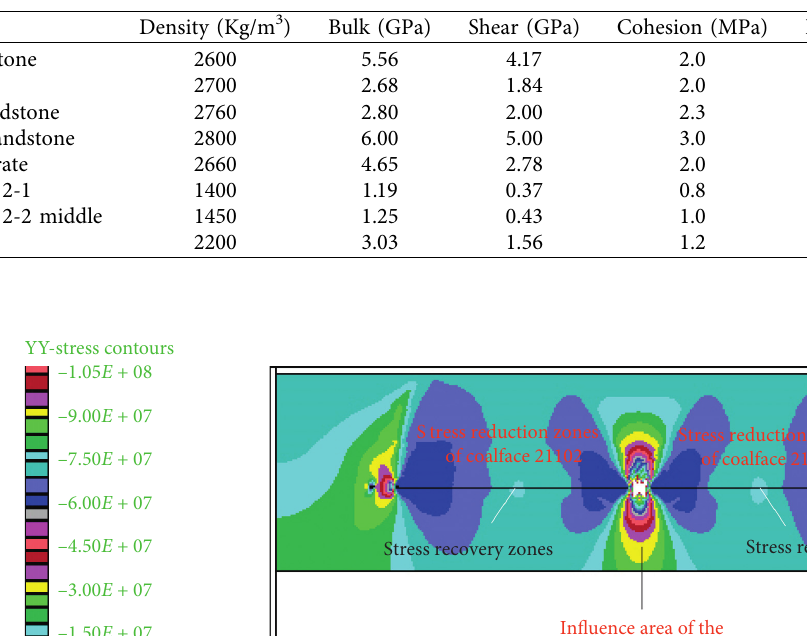
Figure 4: FLAC numerical model after mining the protective seam. Table 1: Properties of coal and rock mass used in the numerical model.